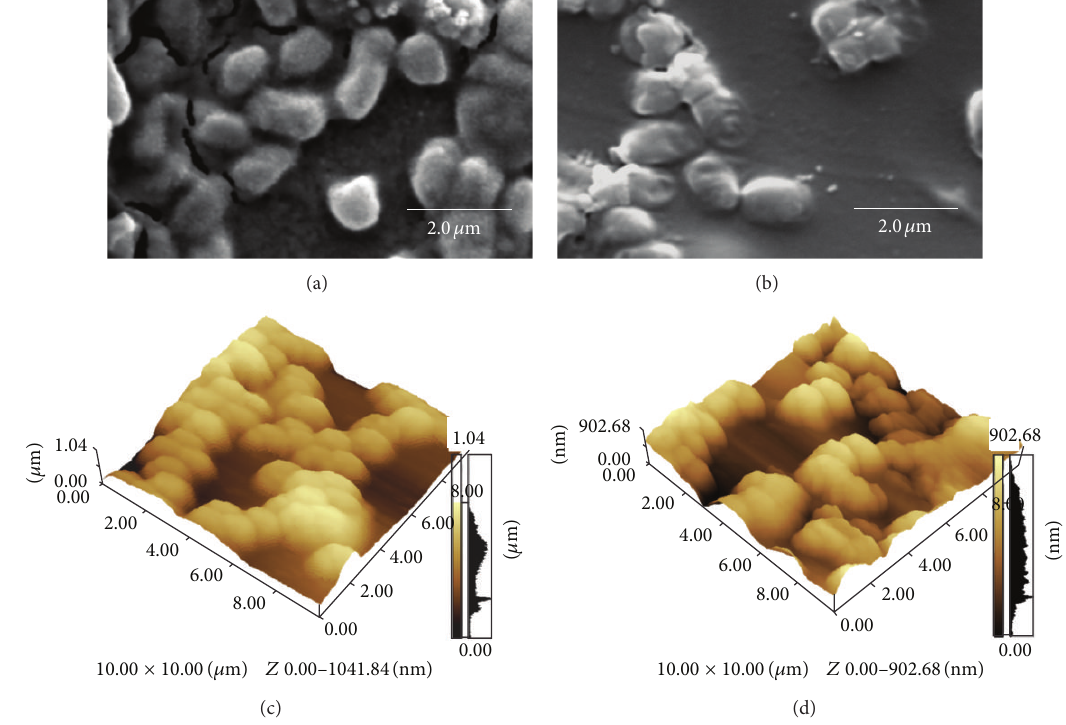
Figure 1: High-vacuum scanning electron micrographs and atomic force microscopy of K. pneumonia subsp. pneumoniae . SEM ((a) and (b)) and AFM in 3D ((c) and (d)) micrographs showing cell aggregates and biofilm on glass ((a) and (c)) and polyester ((b) and (d)).